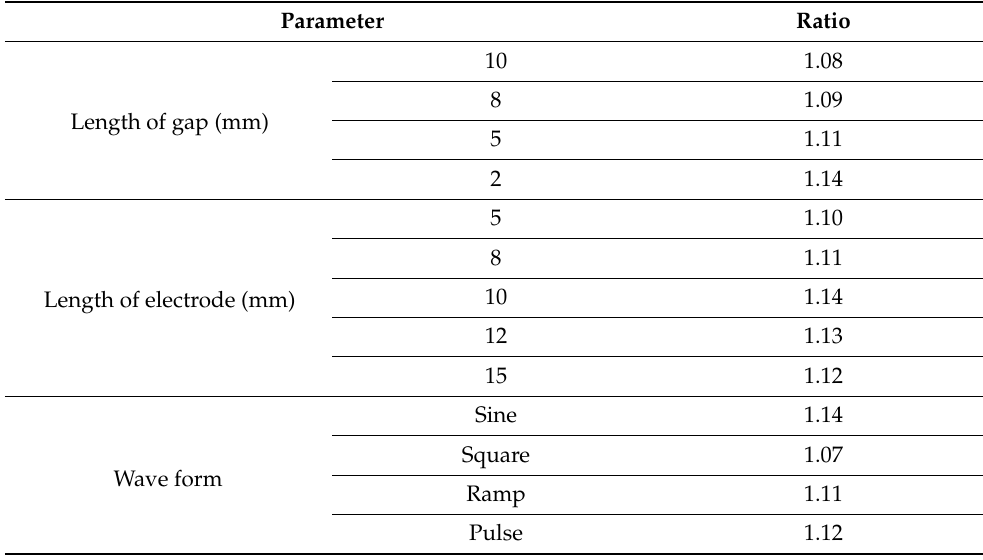
Table 1. The result of researching the ratio of the output waveform.